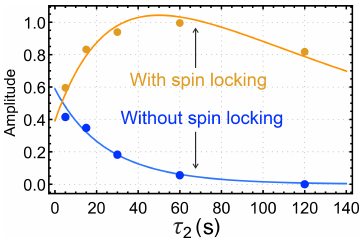
Figure 5. Dependence of the integrated gem -PHIP signal ampli- tudes of the CH 2 protons of I on the interval τ 2 in the pulse se- quences of Fig. 3b and c, with τ 1 fixed to 17s. The orange sym- bols show the amplitudes for the case of a spin-locking field during the τ 2 interval (sequence in Fig. 3b), with an amplitude correspond- ing to the nutation frequency ω nut / 2 π = 1 . 0kHz. The blue symbols show the amplitudes for experiments without a spin-locking field during the τ 2 interval (sequence in Fig. 3c). The orange and blue solid lines show the functions a b ( τ 2 ) and a c ( τ 2 ) (Eqs. 19 and 23, = 151s, T H 2 = 28 . 7s, T I = respectively), with the parameters T I zz (cid:54) S